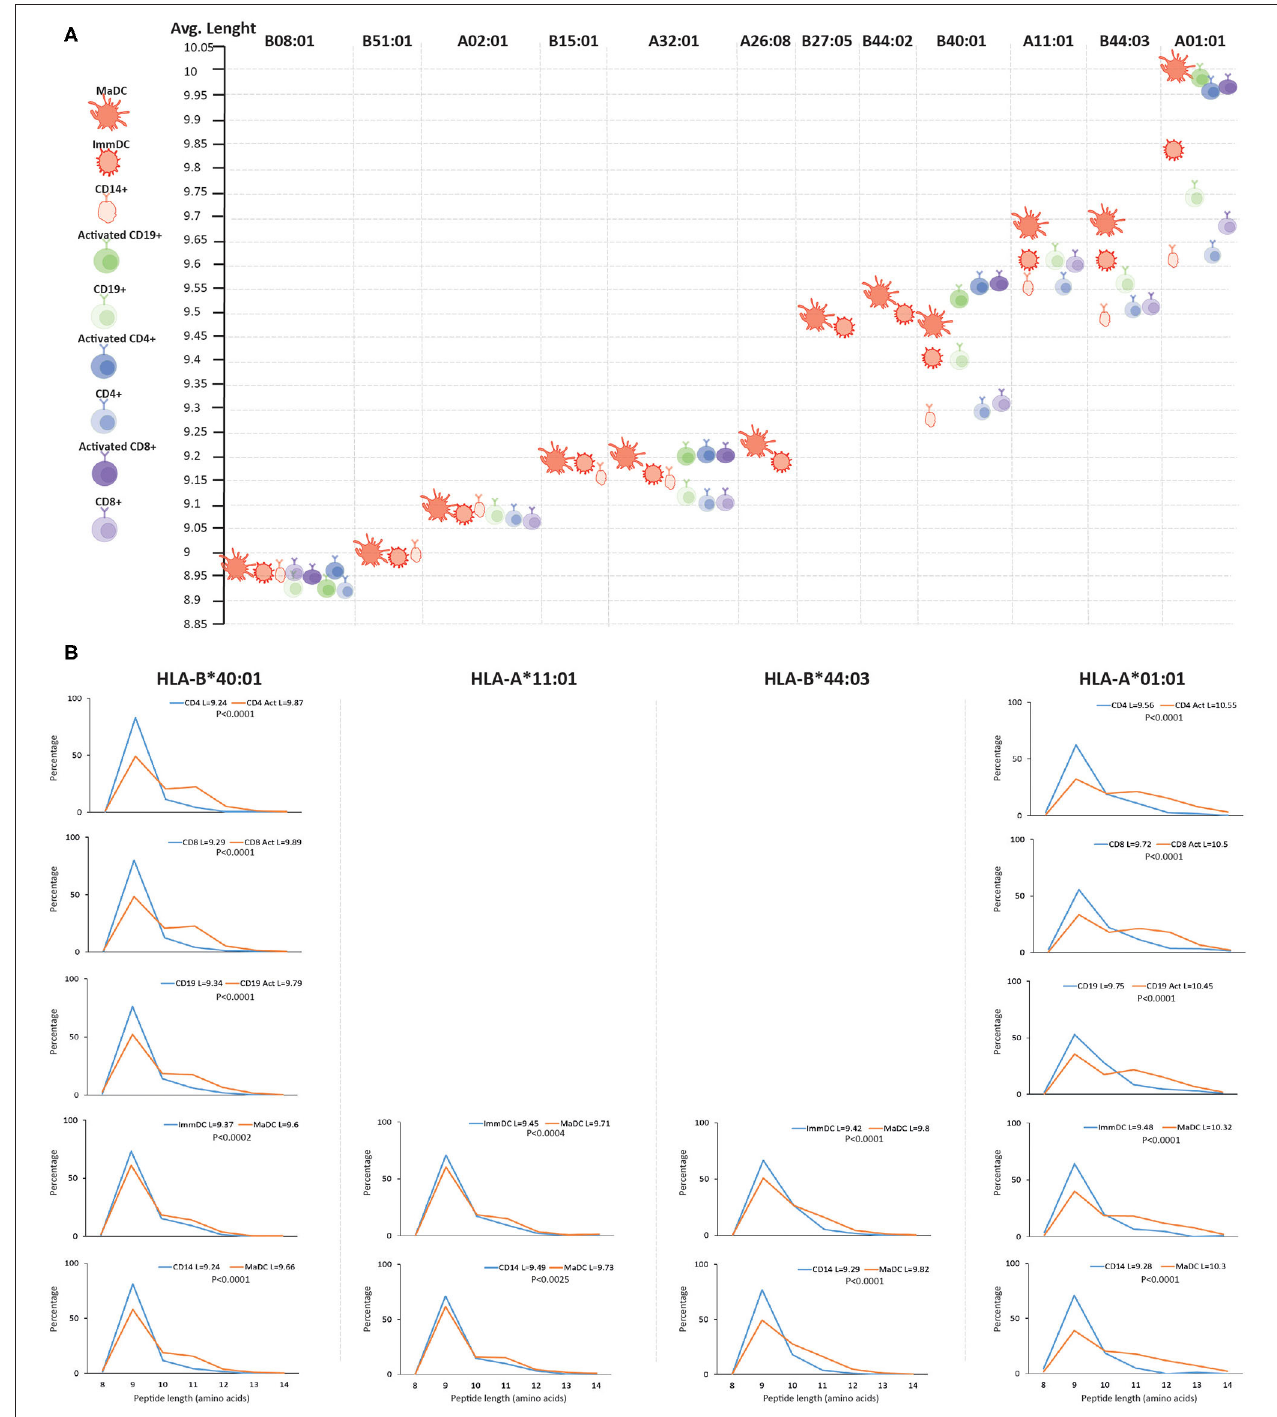
FIGURE 2 | Length distribution of HLA class I peptides upon differentiation and activation of immune cells. (A) Length distribution across different HLA class I alleles of naive and activated immune cells. For each donor, MS detected ligands (length 8–14) were separately assigned to each of the HLA alleles with NetMHCpan 4.0 and their average length was calculated. HLA alleles are displayed from left to right based on their increasing propensity to bind longer peptides. (B) Length distributions (length 8–14) of unique HLA-I peptides presented in activated vs. unstimulated immune cells of HLA alleles which are expected to accommodate longer peptides. Average length (L) for each cell type is reported together with the statistical significance (unpaired t -test, p -values).